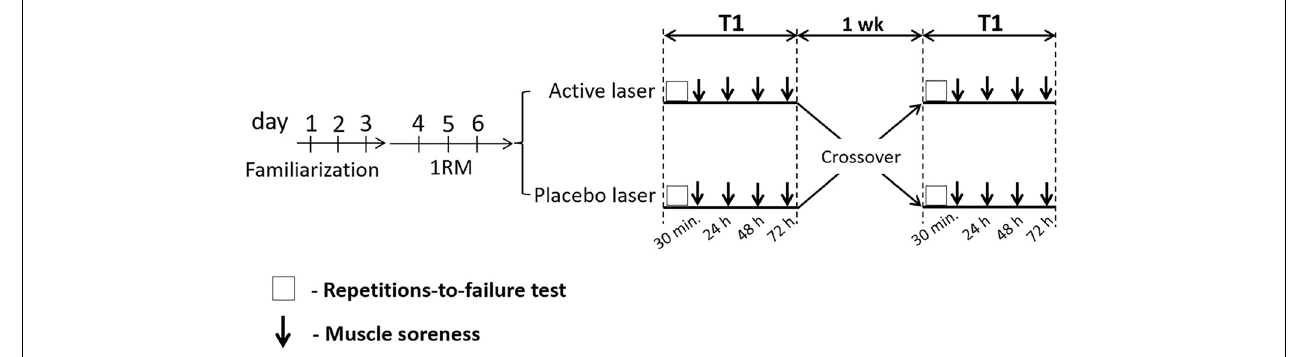
FIGURE 1 | Experimental